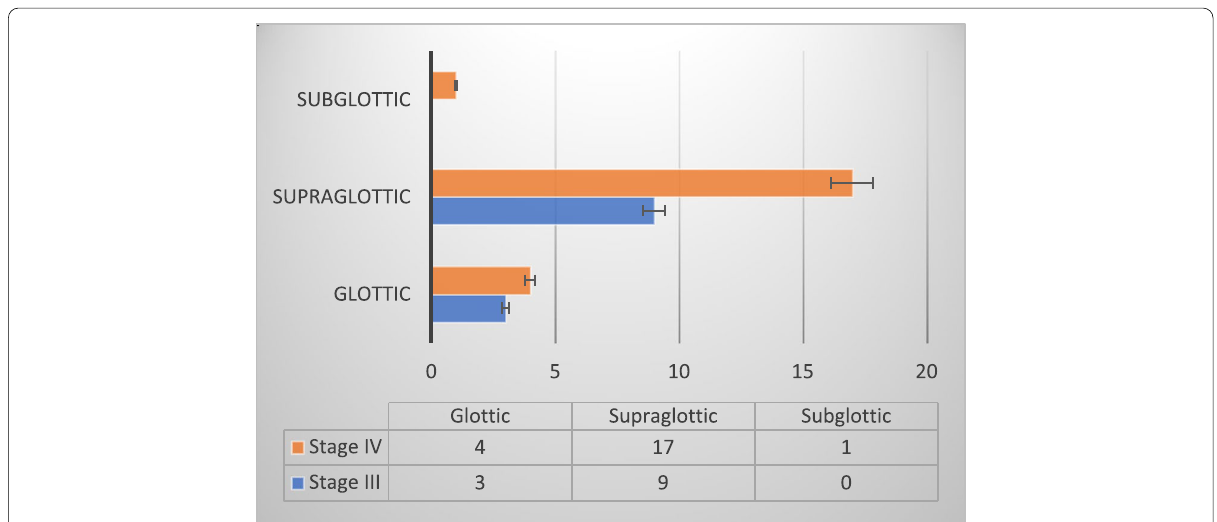
Fig. 2 Distribution of site of carcinoma by stage of disease